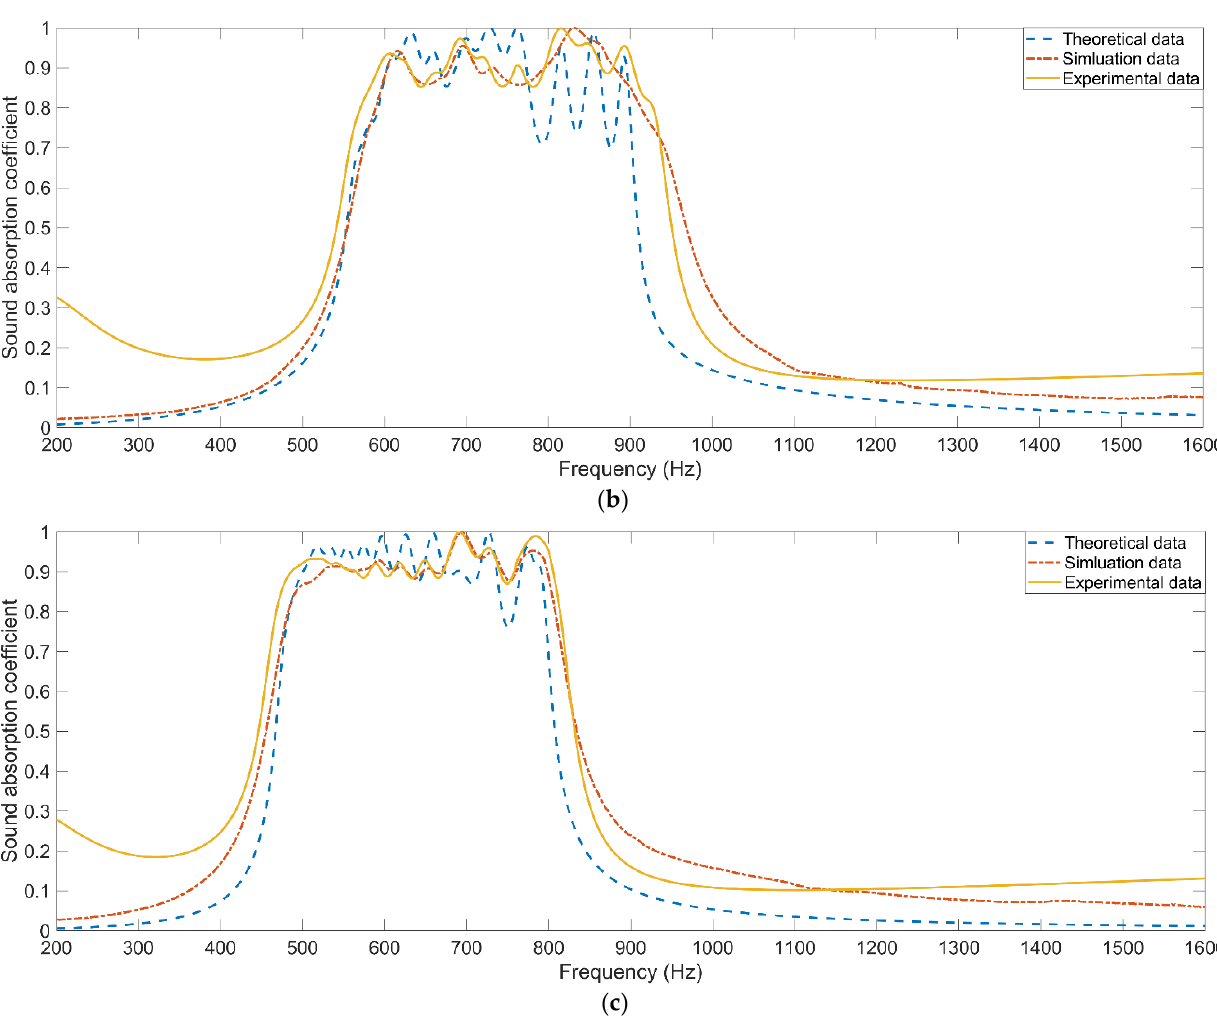
(15) Table 5. The average absolute deviations of simulation data and theoretical data by comparison with experimental data. Condition Serial